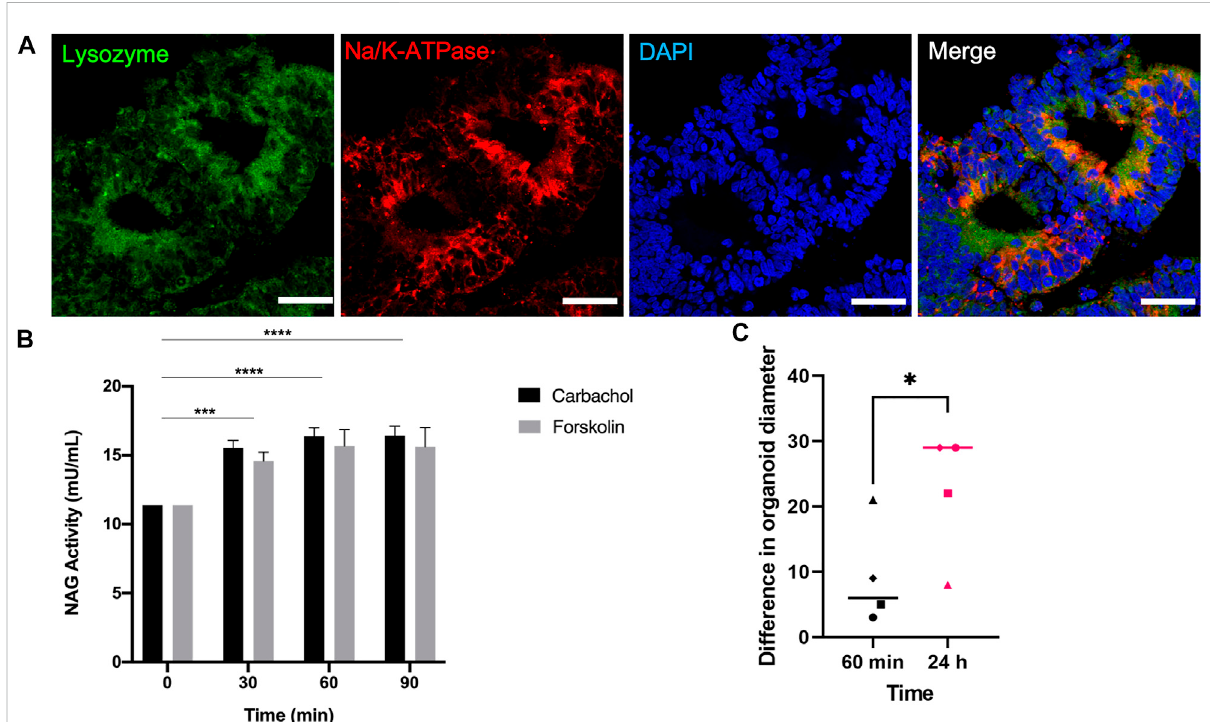
FIGURE 6 Expression of the functionality marker lysozyme and secretory levels of the active lysozyme enzyme NAG on day 40 of differentiation (A) IF stainingofLysozyme+/Na+/K+ATPaselacrimalglandacinarcells(Figuresarerepresentativeofthreeindependentdifferentiationexperiments,scale bar: 40 µm) (B) NAG concentration in the supernatant of lacrimal gland organoids following carbachol and forskolin stimulation (Two-Way ANOVA. Error bars represent standard error of mean. *** p ≤ .001; **** p ≤ .0001, n = 3 biological replicates). (C) Swelling of organoids